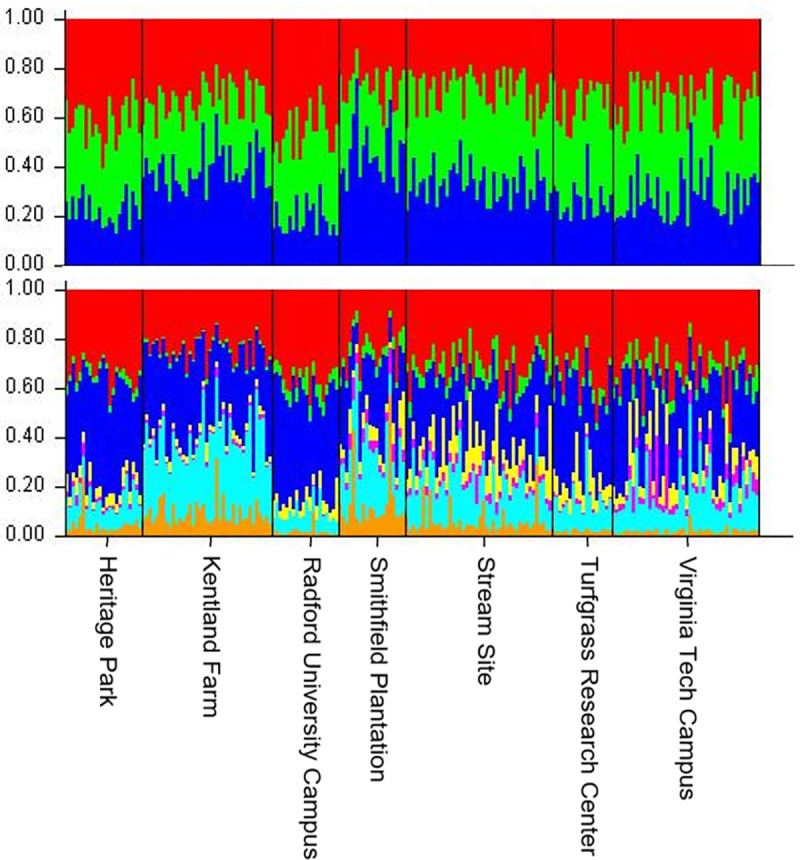
Structure barplot for (a) K = 3, (b) K = 7, sorted by sampling site and showing proportional membership for each individual in each identified genetic cluster. Each vertical bar represents an individual, each color indicates a cluster, while bar height specifies proportional affiliation to each cluster. The observed pattern, in which all individuals are affiliated similarly with each cluster, is consistent with a lack of population genetic structure.